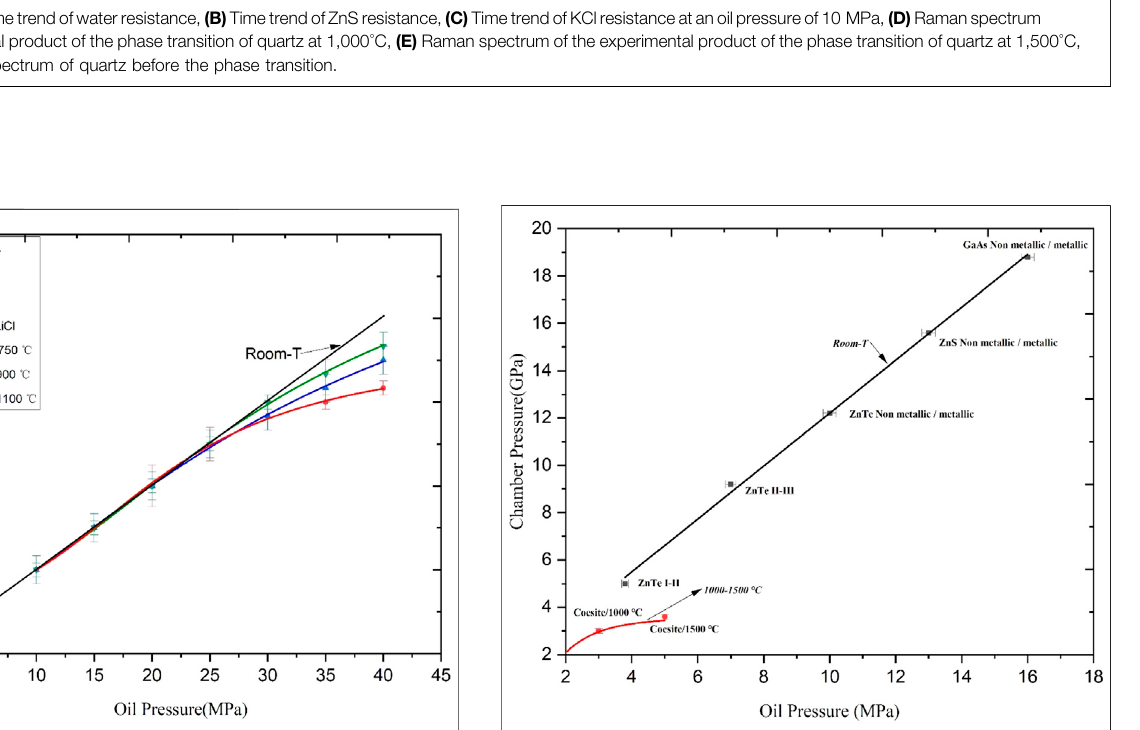
Frontiers in Earth Science |